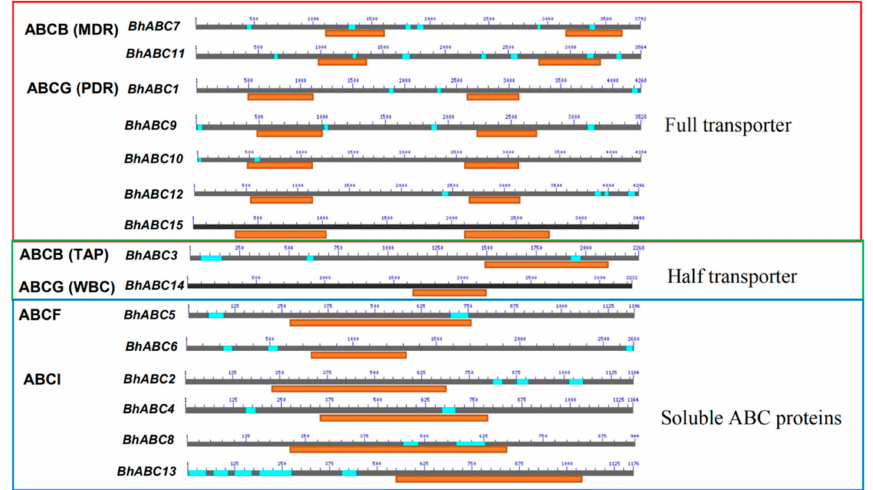
Figure 1. Prediction of conserved domains of BhABC genes. Gray areas represent exons, blue areas represent introns, and orange areas represent locations of nucleotide-binding domains (NBDs).